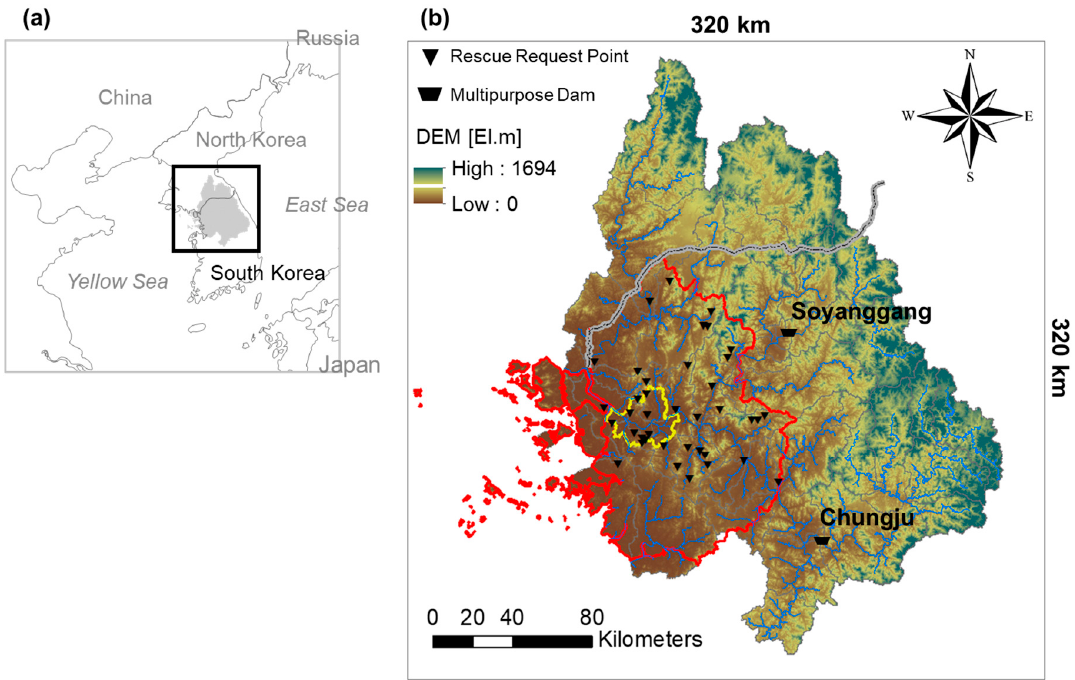
Figure 2. The study area in Korea. ( a ) The black box represents the model domain with grid spacing of 1 km. The shaded area represents the Han River basin. The black line crossing from west to east in the shaded area represents the Demilitarized Zone (DMZ) separating South Korea and North Korea. ( b ) Numerical model domain for the TOPLATS model (black box in Figure 2a). Color bar indicates the DEM elevation in m, and the blue lines show the river network. The black triangles and trapezoids indicate the rescue request points and major dams, respectively. The red line encircles the Seoul Capital Region and the yellow line encircles Seoul. The thick gray line crossing from west to east indicates the DMZ.